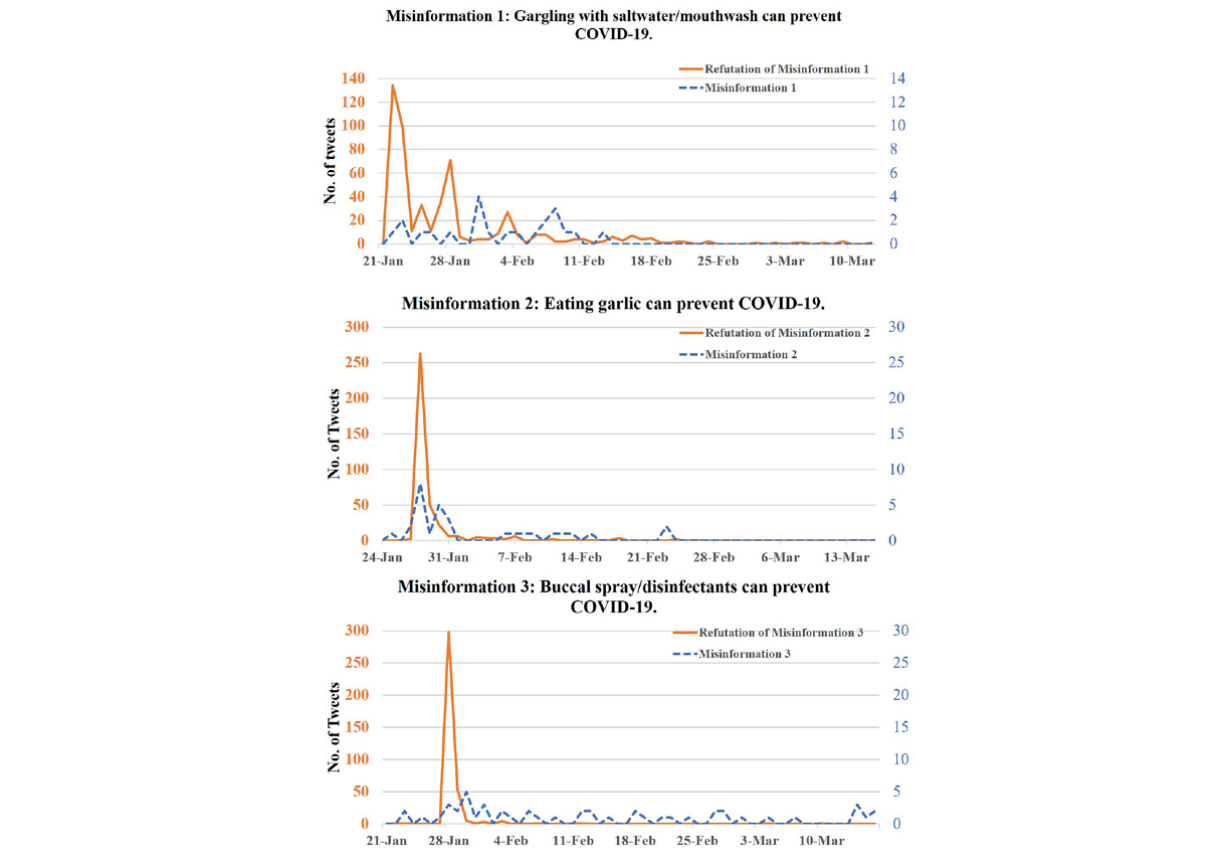
Figure 5. The time distributions of tweets related to misinformation for COVID-19 prevention and its refutations. COVID-19: coronavirus